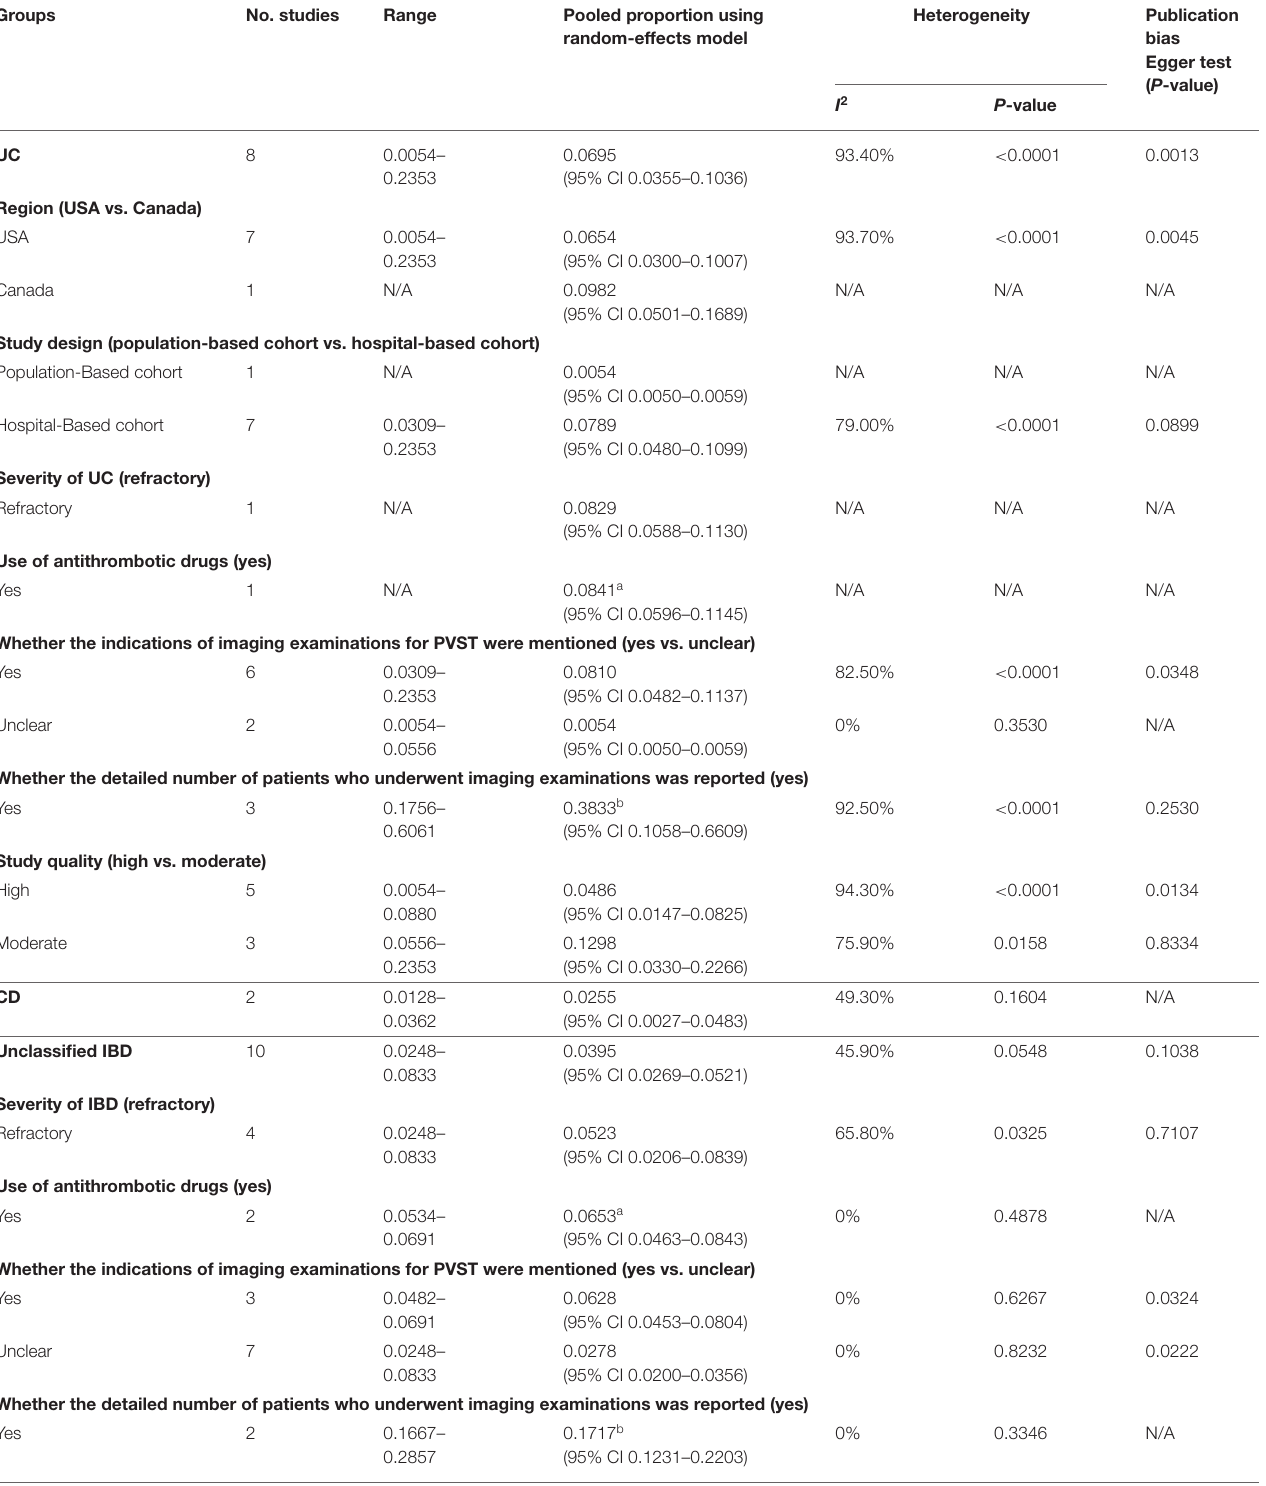
TABLE 4 | Incidence of PVST in patients with IBD after colorectal surgery.